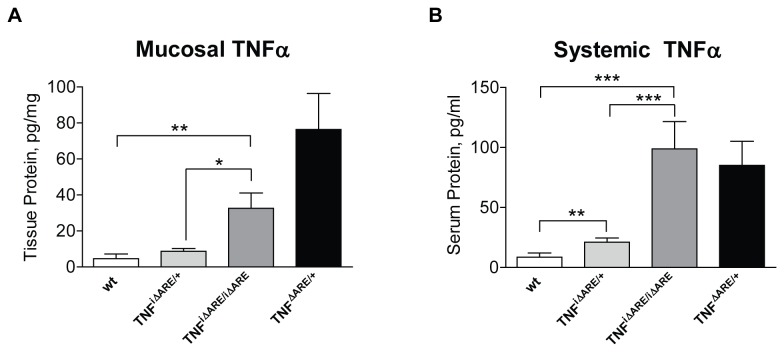
Mucosal and systemic expression of TNFα protein is elevated in TNFi∆ARE/i∆ARE mice.Intestinal epithelial-specific overexpression of TNFα was induced by expressing the tnf
ΔARE mutation under the promoter of the intestinal-specific I-FABP gene, which is expressed primarily by IECs. (A) Pieces of small intestinal tissue were homogenized at the time of animal sacrifice, and the concentration of TNFα protein was measured by ELISA. Values are expressed as pg of TNFα per mg of total protein content, which was measured by a Bradford Protein Assay. (B) Blood was drawn from mice by cardiac puncture at the time of sacrifice. Serum was collected and stored until use. The concentration of TNFα protein was measured by ELISA. Murine ileal tissue and sera were analyzed individually. A significant increase in the total protein content in both small intestinal tissue homogenates and murine sera was seen in homozygous TNFi∆ARE/i∆ARE mice (n=11), as compared with either heterozygous TNFi∆ARE/+, (n=10) or wt mice (combined wt for TNFi∆ARE/i∆ARE and systemic TNFΔARE/+, n=16). Mice with systemic overexpression of TNFα were included in the analysis, serving as positive controls (TNFΔARE/+ mice, n=6). Graphs represent mean values ± SEM for each experimental group of mice. *P<0.05, ** < P<0.01, *P<0.001.